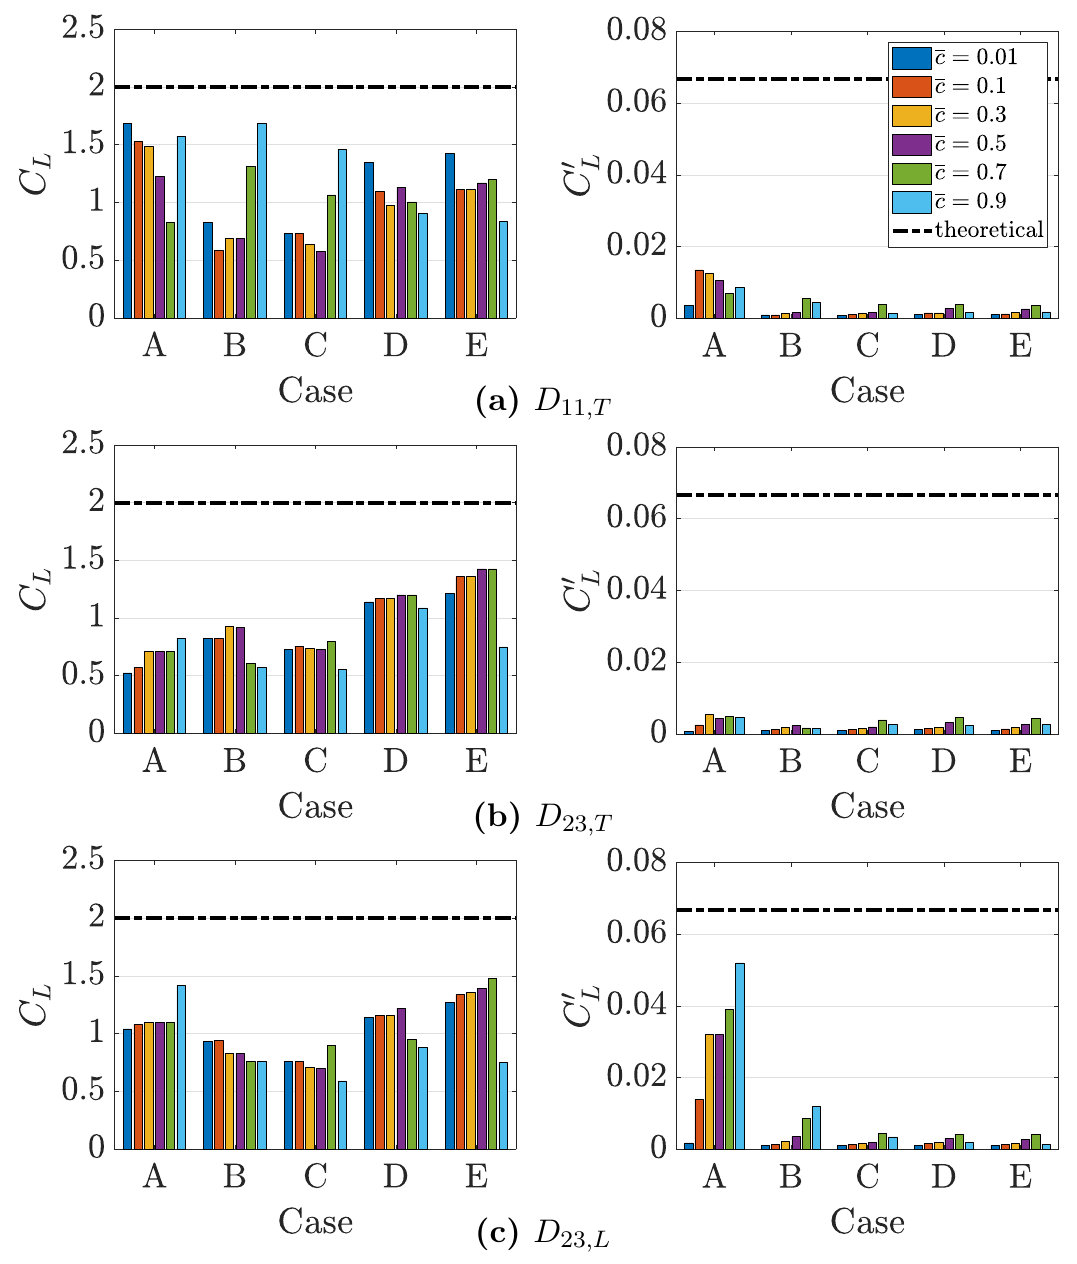
Figure 5. Variations of the proportionality parameters (i.e., C L = 5: Variations of the proportionality parameters (i.e. C